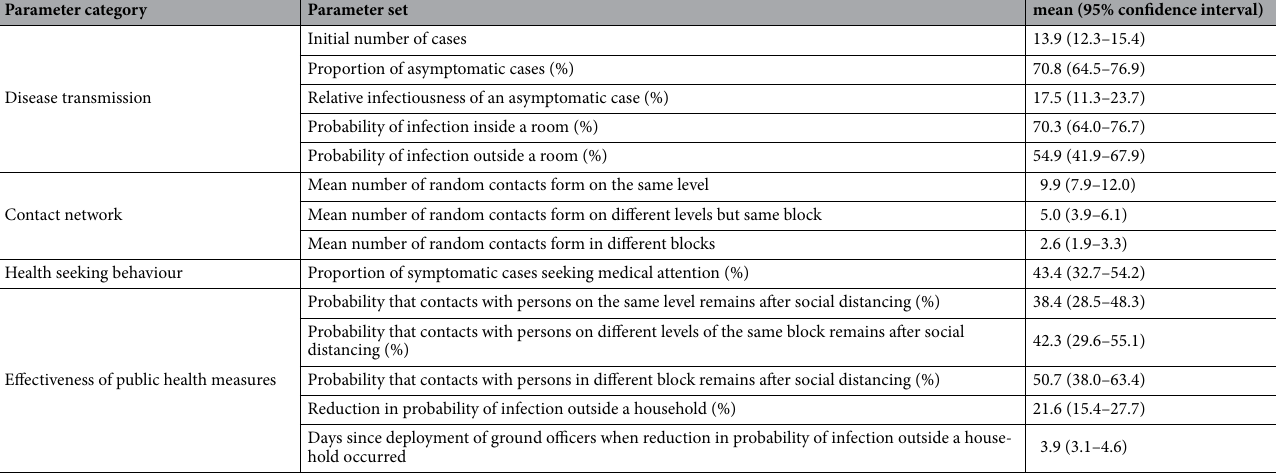
Table 1. Combination of factors that reproduced similar outbreak observations in the dormitory under study.